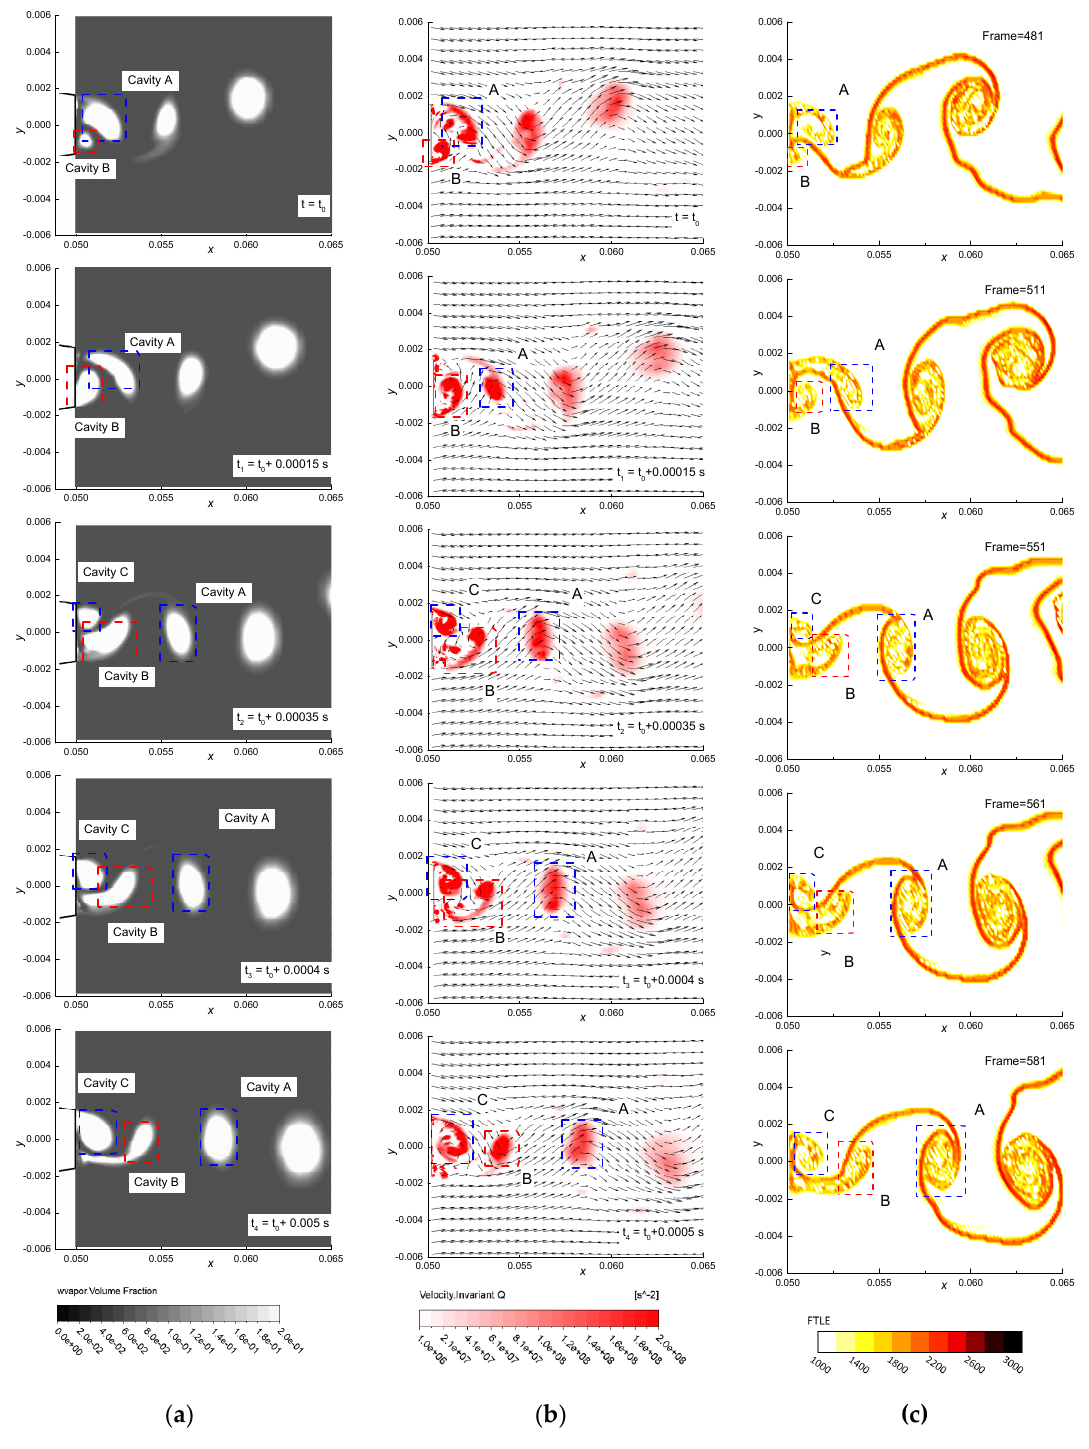
Figure 10. Plot for cavitation conditions ( σ / σ i = 0.6) at five correlative instants of time from top to bottom of: ( a ) vapor volume fraction distribution; ( b ) the instantaneous Eulerian Q criterion superposed to the instantaneous velocity; and ( c ) the backward finite-time Lyapunov exponent (FTLE).